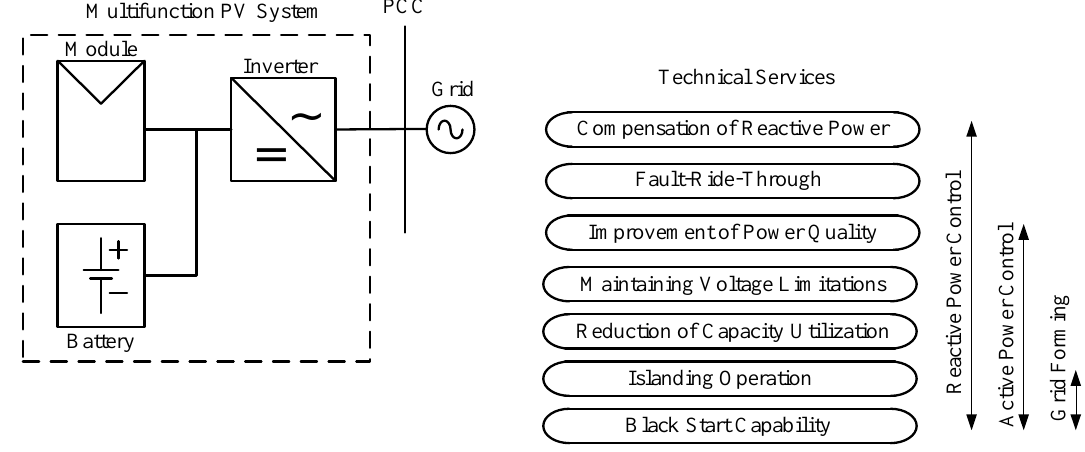
Figure 5. Services provided by PV systems.